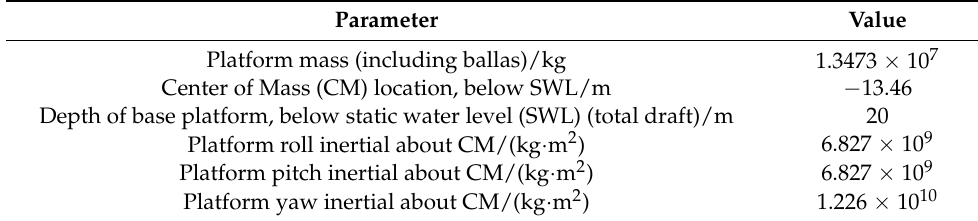
Table 2. Parameter of OC4-DeepCwind semi-submersible